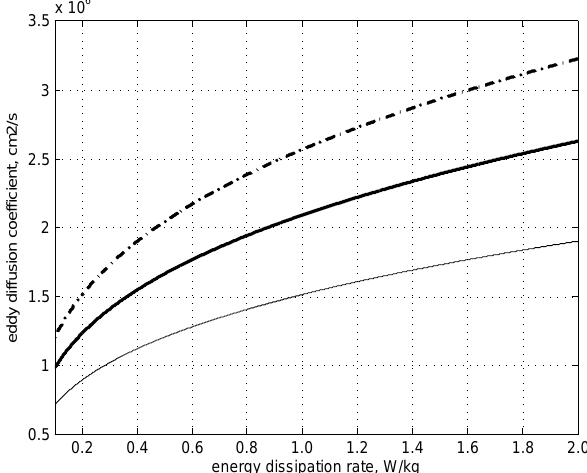
Figure 1. The K ed maximum value vs. the energy dissipation rate calculated by Eq. (12) with b = 0.8 and L B = 600 and 700m (thick solid and thick dashed-dotted curves, respectively), b = 0.3 ( P = 1, Ri = 0.25), and L B = 600 (thin solid